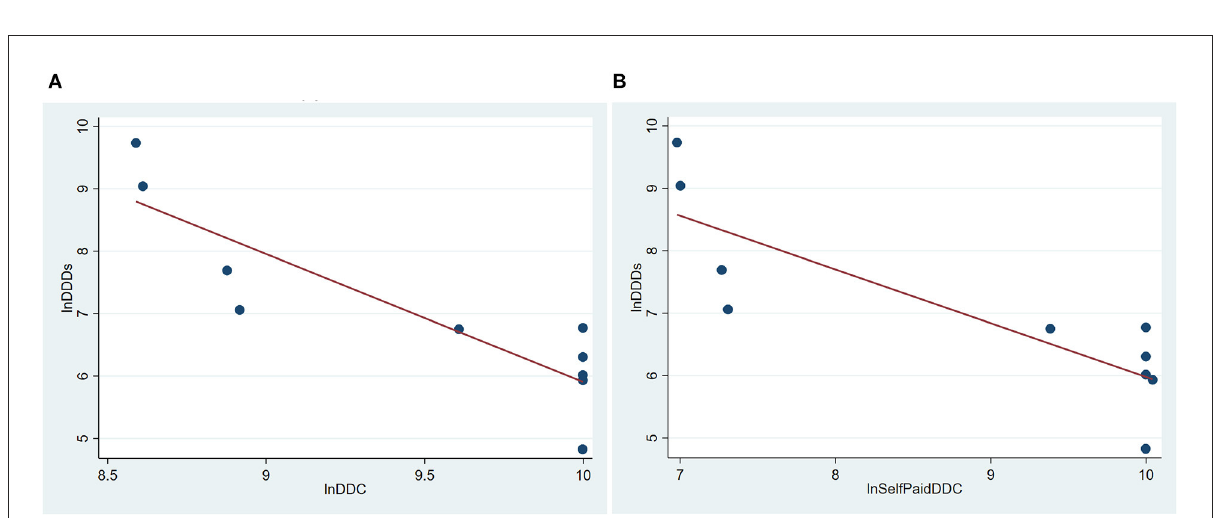
FIGURE4 Correlation of DDC and DDDs of trastuzumab in Nanjing from 2012 to 2021. (A) Correlation between total DDC and DDDs of trastuzumab in Nanjing from 2012 to 2021; (B) Correlation between self-paid DDC and DDDs of trastuzumab in Nanjing from 2012 to 2021. DDDs, defined daily doses; DDC, defined daily